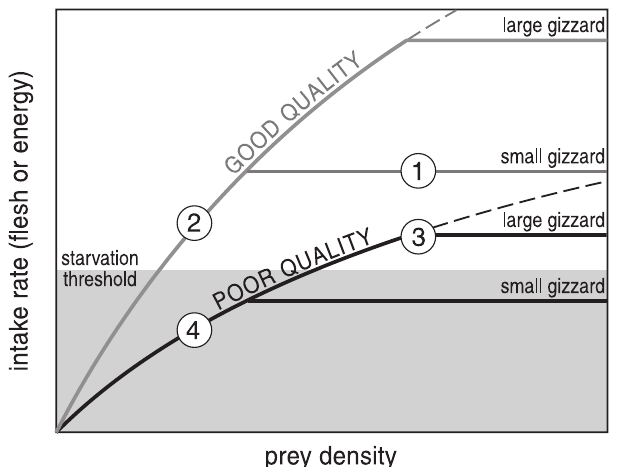
Figure 1. Conceptualization of Why a Simultaneous Reduction in Density and Quality of the Prey is Detrimental Holling’s Type II functional response describes intake rate (be it flesh or energy) as a function of the density of either poor-quality (black lines) or good-quality (gray lines) prey. Digestive constraint limits shell-mass processing rate and is given for two gizzard sizes for each prey quality (horizontal cut-offs in functional response; digestively unconstrained intake rates continue as dashed lines). By knowing the threshold intake rate needed to avoid starvation (border between gray and white background), one can predict a bird’s starvation chances on the basis of gizzard size and prey quality and density. (1) A small gizzard is sufficient to stay alive when prey is of good quality and occurs in high densities. Going from (1) to (2), prey density is reduced, which does not affect survival as intake rate remains above the critical threshold. Going from (1) to (3), prey quality (flesh-to-shell ratio) is reduced. To maintain a sufficient intake rate, the knot needs to increase its shell-mass processing rate, which requires a gizzard enlargement. Going from (1) to (4), the combined reduction in density and quality makes a gizzard enlargement no longer sufficient (as intake rate is now constrained by prey density), and the bird is bound to